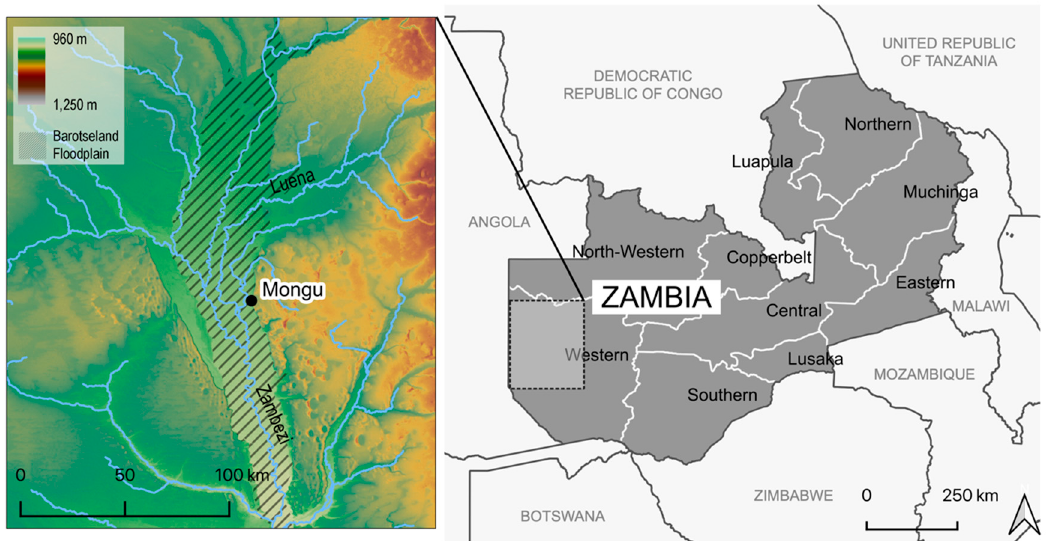
Figure 2. Location of the study site, Barotseland, Western Zambia. Digital elevation data from SRTM 3-second arc product. Location of the Zambezi and Luena Rivers are denoted, alongside the extent of the Barotse Floodplain that forms the Upper Zambezi catchment.